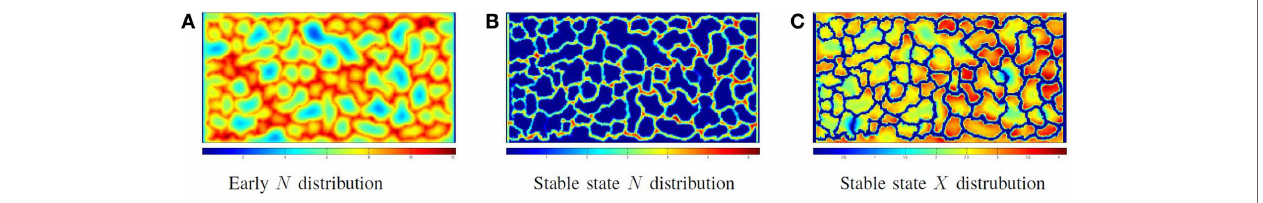
FIGURE 7 | Phase III: running the factory: the distribution of nutrient (A) when the vessel flow begins, but the producer cells are not yet active and (B) at steady-state nutrient distribution when the factory is running; note that all extravessel nutrient is consumed . (C) The product distribution when the factory is